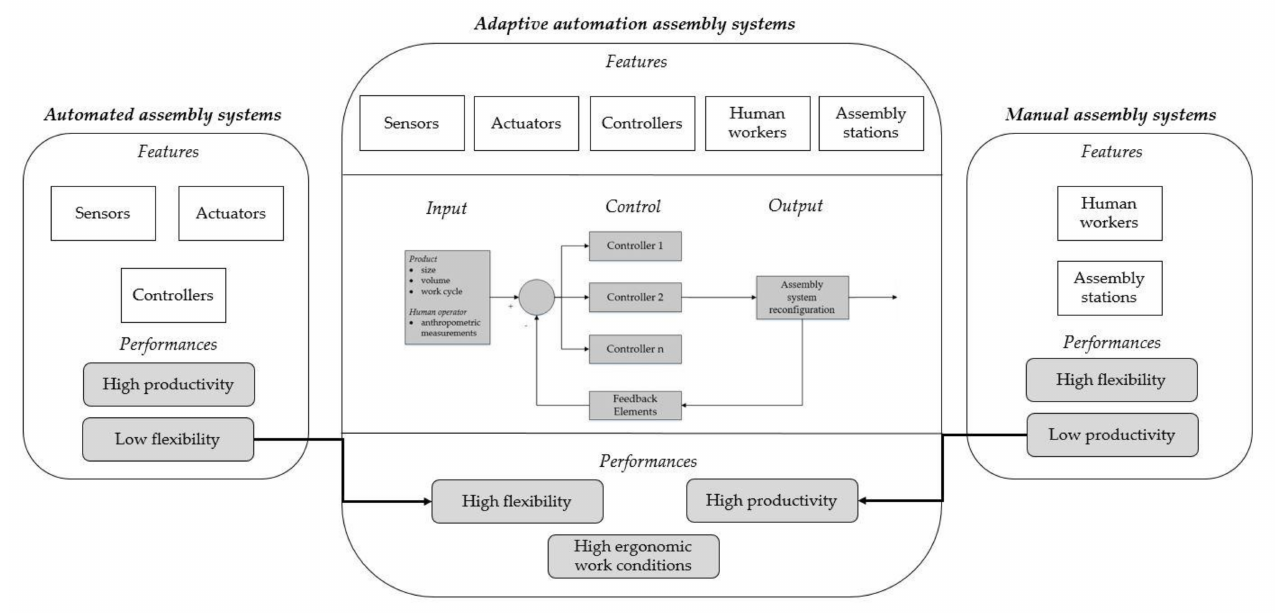
Figure 1. New methodological framework for A3S design and